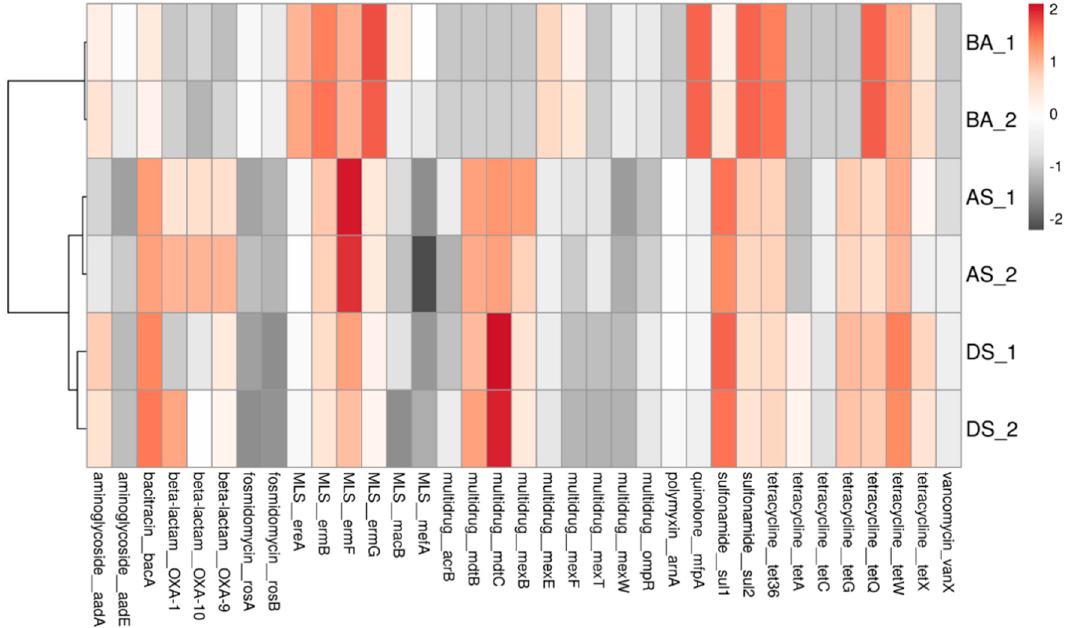
Figure 2. Broad-spectrum profiles of the ARG subtypes in AS (activated sludge), DS (dewatered sludge), and BA (bioaerosols). The abundances of the top 35 ARG subtypes (ARG per copy of 16S rRNA gene copies) are illustrated in the heat map using the normalized z-score for all samples. AS1, DS1, and BA1 indicate January samples in 2015, and AS2, DS2, and BA2 indicate November samples in 2015.